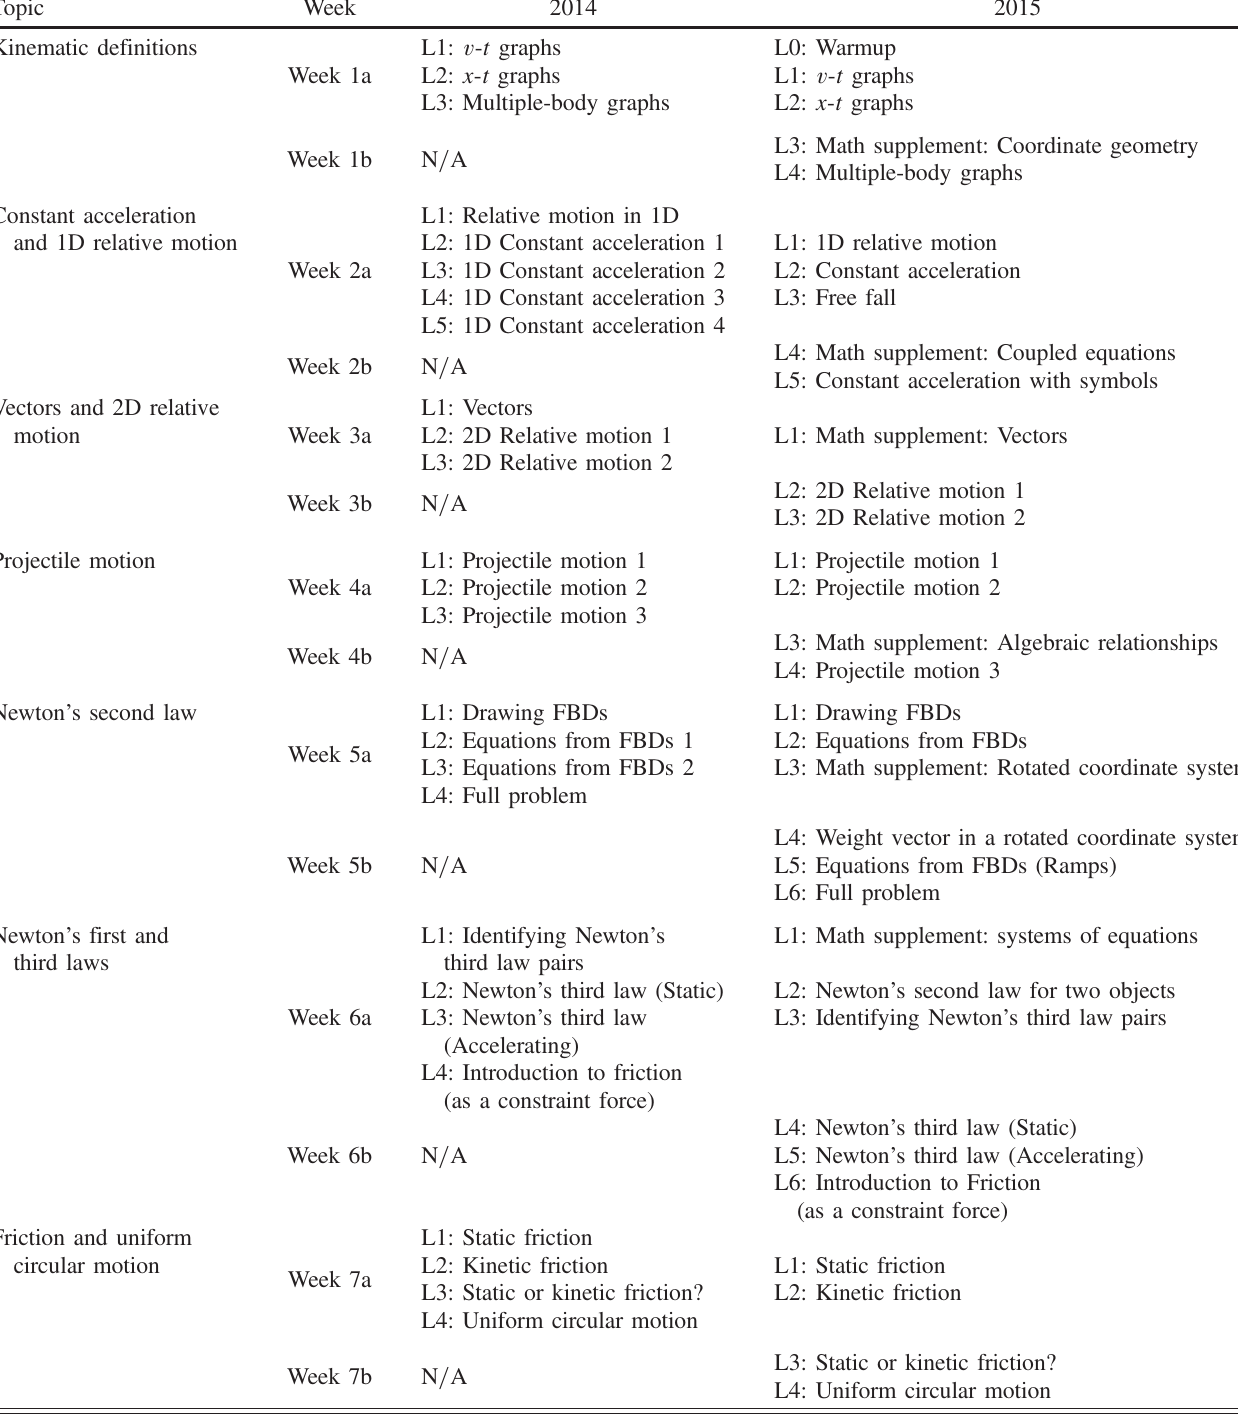
TABLE I. List of levels from 2014 and 2015. Levels were given as one assignment in 2014 and broken into two biweekly assignments for